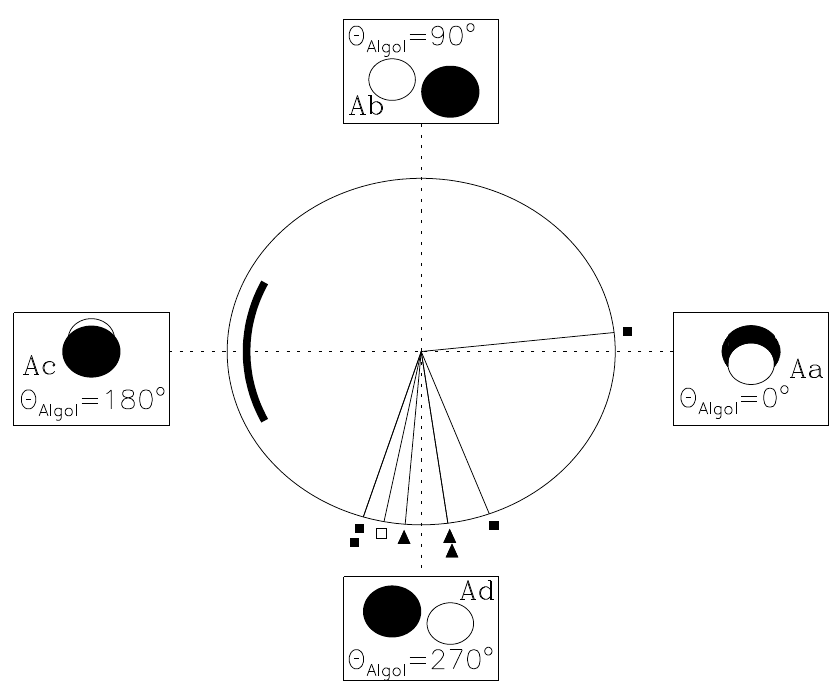
Figure 2. Θ Algol of unlucky time points of Table 2. Notations as in Figure